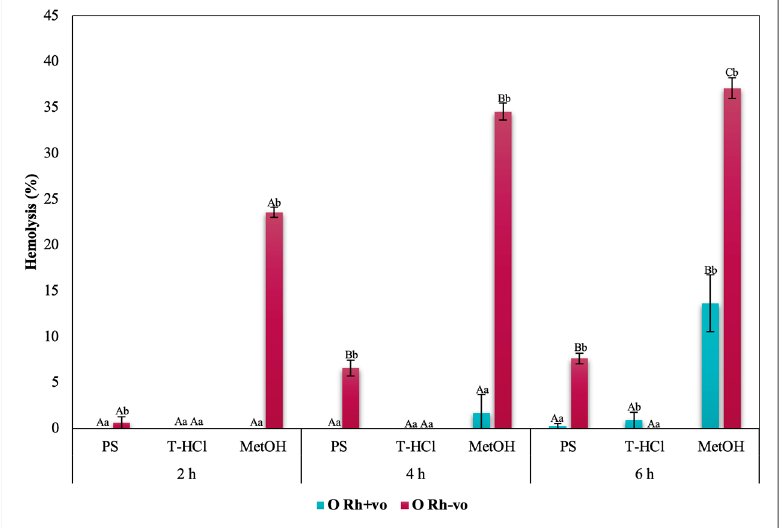
Figure 7. Blood biocompatibility assay of P. cruentum extracts on human erythrocytes with different RhD (positive and negative) of O blood group. Different letters represent significant differences in the means between treatments and groups ( p ≤ 0.001). Capital letters represent a two-way ANOVA. Lowercase letters represent a univariate ANOVA between extracts for each exposure period. PS, extract of physiological solution; T-HCl, 0.5 M Tris-HCl extract; MetOH, 99% methanol extract; AA, ascorbic acid; BCT, beta-carotene; FXA, fucoxanthin.